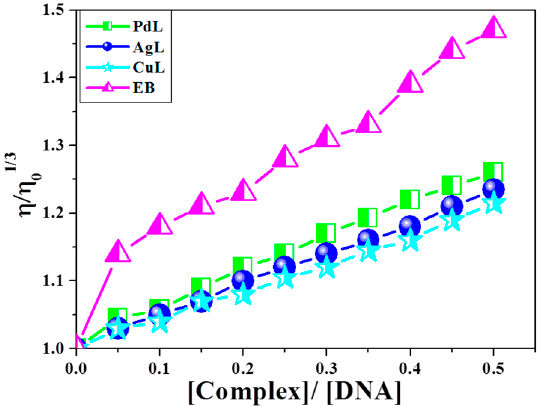
Figure 7. Effect of increasing amount of CuL, PdL and AgL complexes on relative viscosities of CT- DNA at [DNA] = 0.5 mM at 298 K.